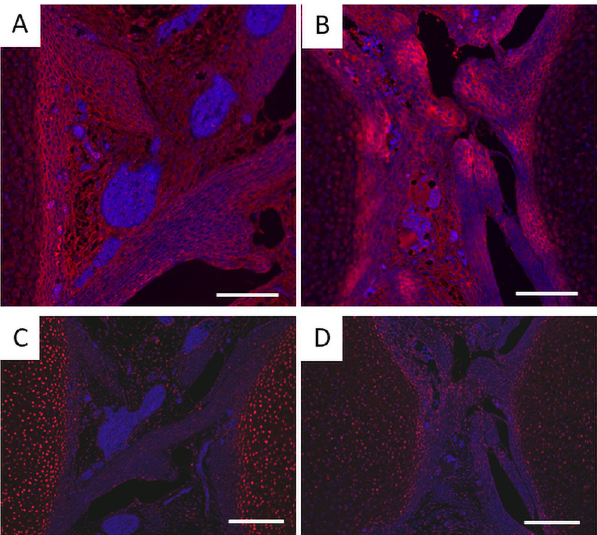
Fig 5. Immunostaining for type I and type II collagens of Prx1-Vcan +/+ (A, C) and Prx1-Vcan (B, D) mice. A, B. Whereas type I collagen is diffusely immunostained in the ligament of Prx1-Vcan +/+ (A), it is observed in spotty patterns in Prx1-Vcan mouse (B). Type I collagen is stained red, and the nuclei are counterstained blue. C, D. Whereas type II collagen is localized in articular chondrocytes of Prx1-Vcan +/+ joint (C), it is immunostained in some cells in the ligament of Prx1-Vcan joint (D) Type II collagen is stained red, and the nuclei are counterstained blue (Bar = 100 μ m).